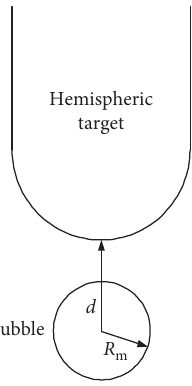
Figure 4: Schematic diagram of related physical quantities in a dimensionless